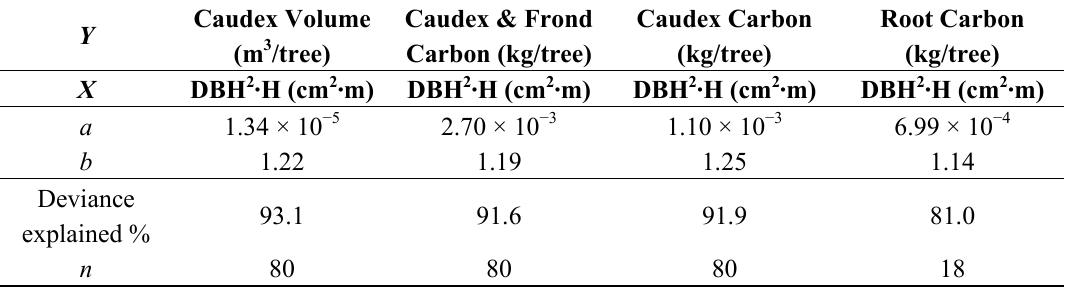
Table 5. Mixed-species allometric equations for estimating caudex volume and component carbon for tree ferns, sample size ( n ), and variance explained. The equation form is Y = aX b